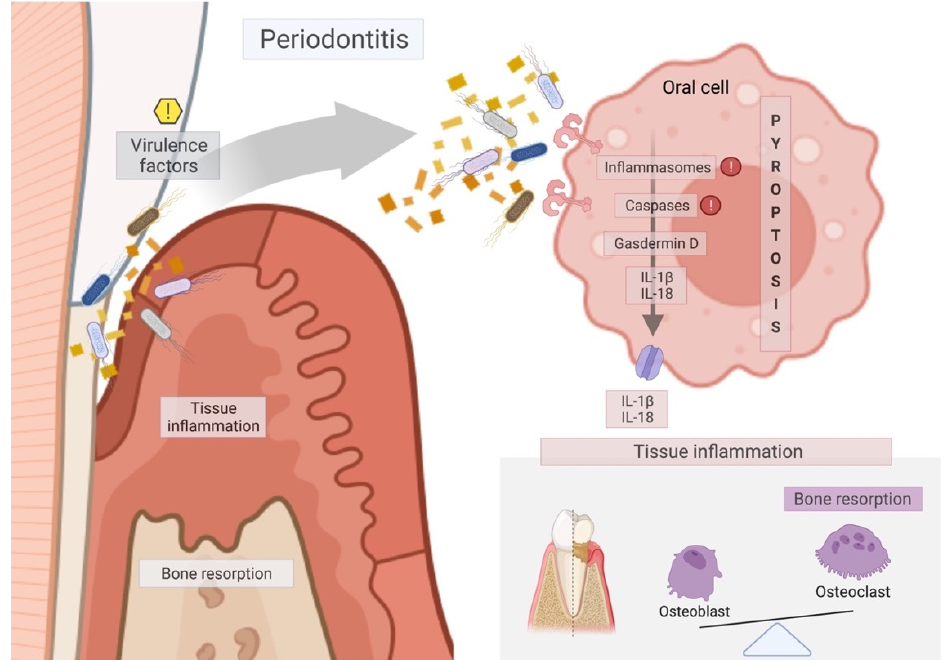
Figure 3. Schematic diagram of the mechanism of pyroptosis pathway on periodontal tissues to the promotion of periodontitis. Virulence factors activate the inflammasome/caspase downstream to the cleavage of Gasdermin D, which is responsible for membrane pore formation and, thus, the release of interleukins IL-1 β and IL-18 to the extracellular environment. Those interleukins lead to tissue inflammation and disruption of the balance between bone formation by the osteoblasts and bone resorption by the osteoclasts, thus aggravating the process of periodontitis through soft tissue inflammation (swelling, bleeding) and marginal bone loss. Red exclamation marks mean the main targets for pyroptosis-specific inhibitors, such as MCC950, Ac-YVAD-CHO, Z-LEVD-FMK, and VX765. Yellow exclamation mark indicates the main target for therapeutic approaches that should act on the virulence factors responsible for triggering pyroptosis on periodontal tissues.